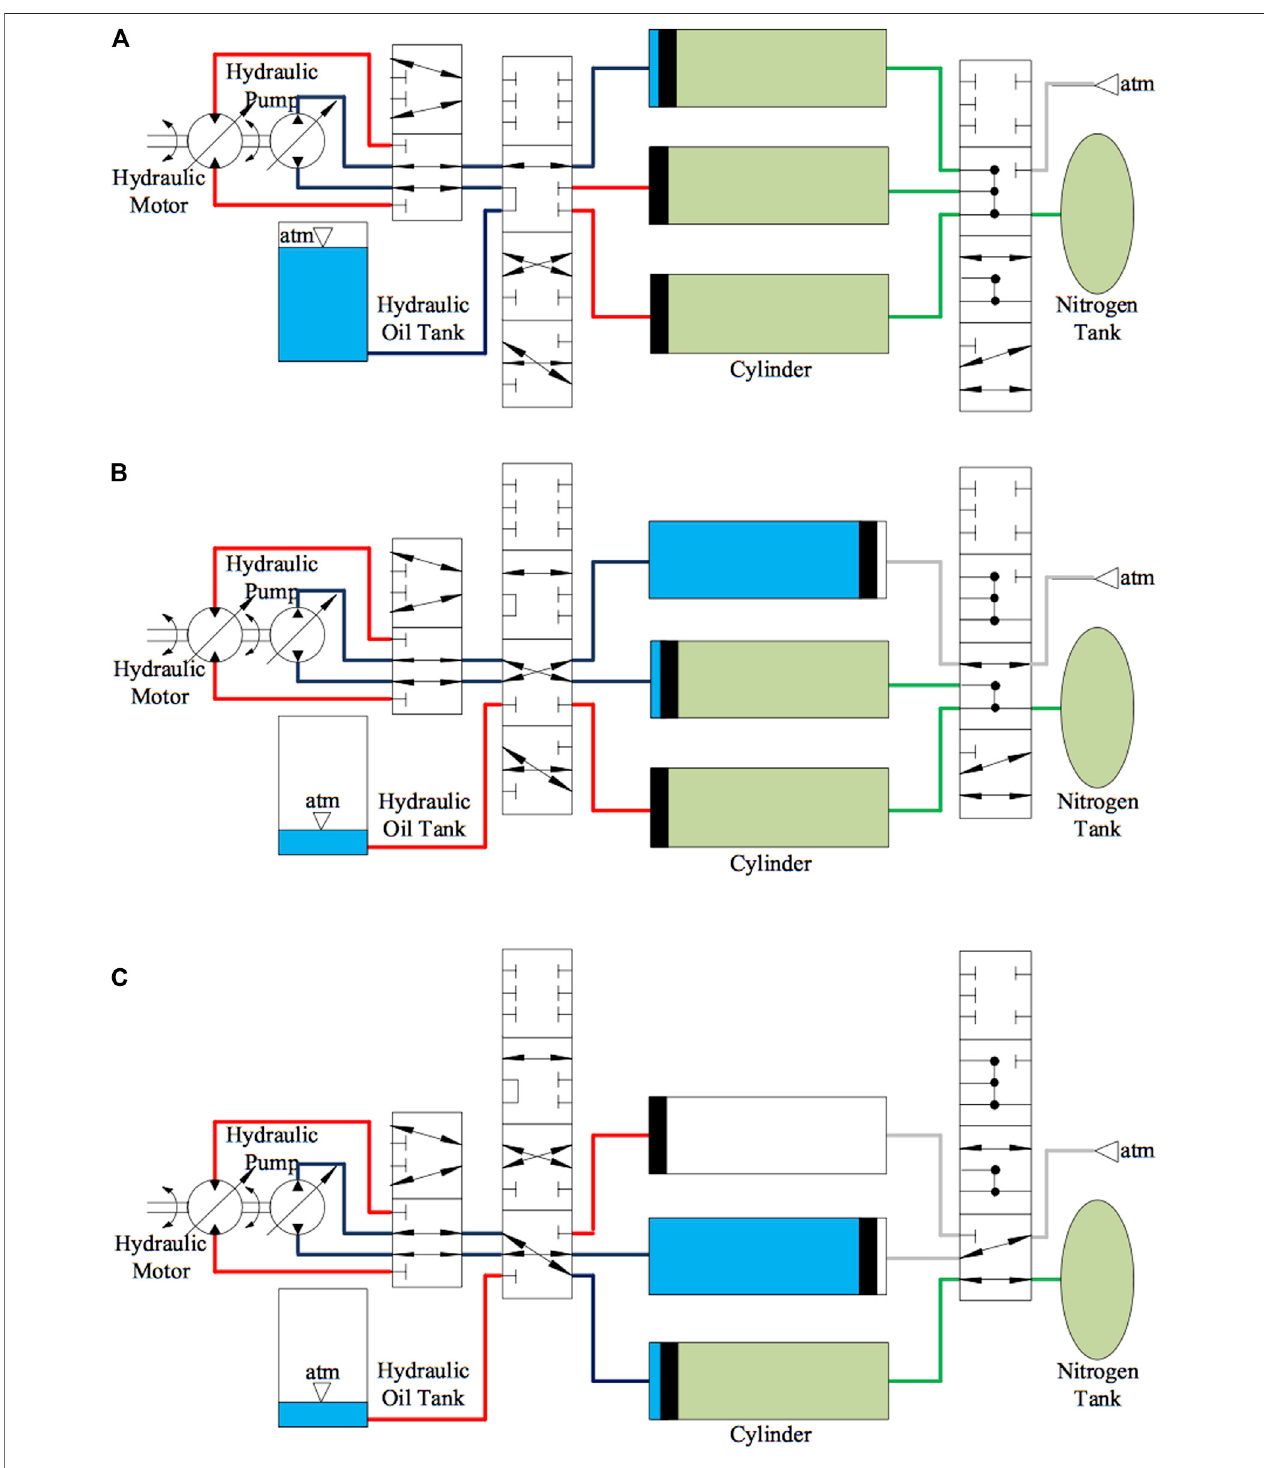
FIGURE 2 | Charging stages (discharging stages) of IHESS: (A) Charging stage I (discharging stage III). (B) Charging stage II (discharging stage II). (C) Charging stage III (discharging stage I).